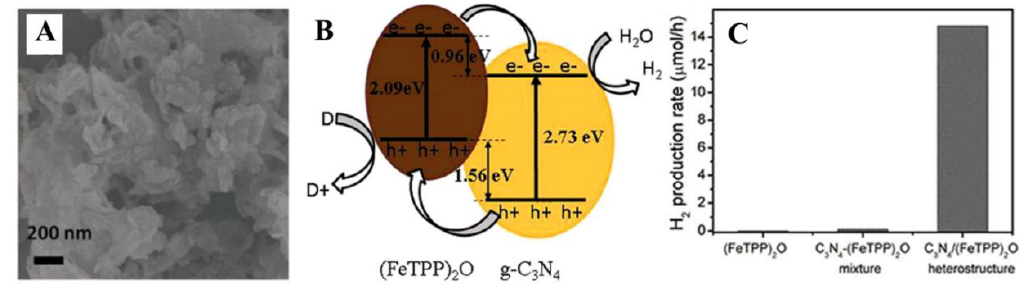
Figure 9. ( A ) SEM image of the graphitic C 3 N 4 (g-C 3 N 4 )/m-oxo dimeric iron (III) porphyrin ((FeTPP) 2